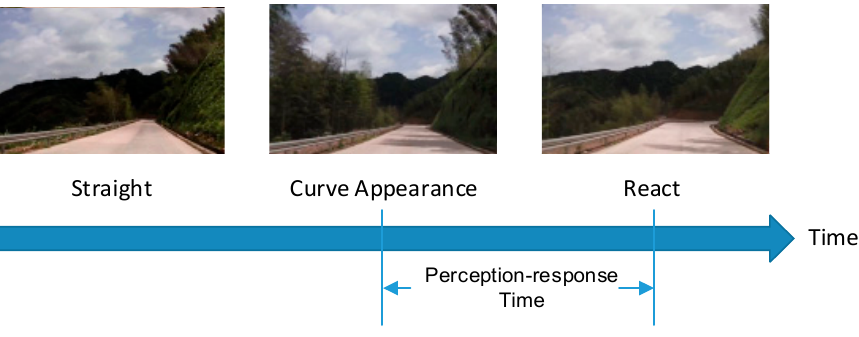
Figure 2. Illustration of perception-response time on a mountain highway curve.